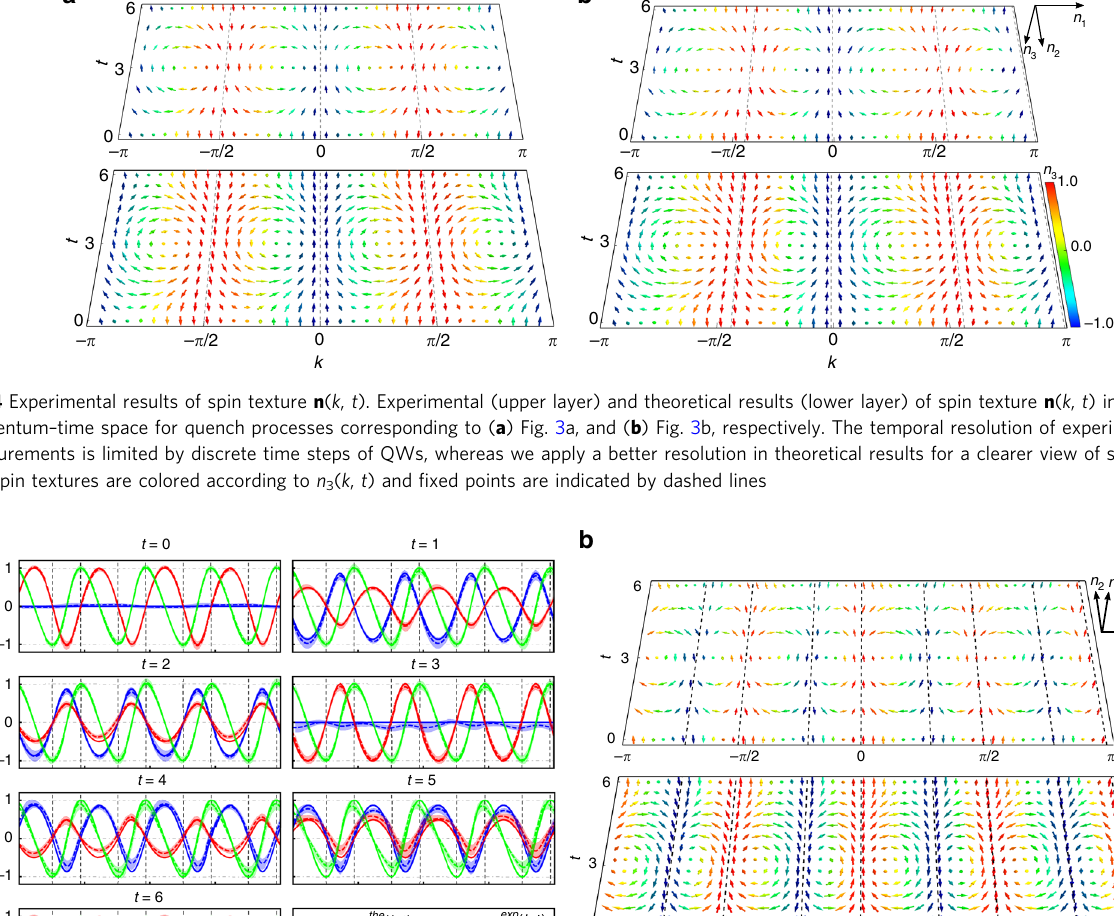
¼ (cid:3) π = 2 ; θ i ¼ (cid:3) π = 4 Þ with ν i = − 2, and 1 2